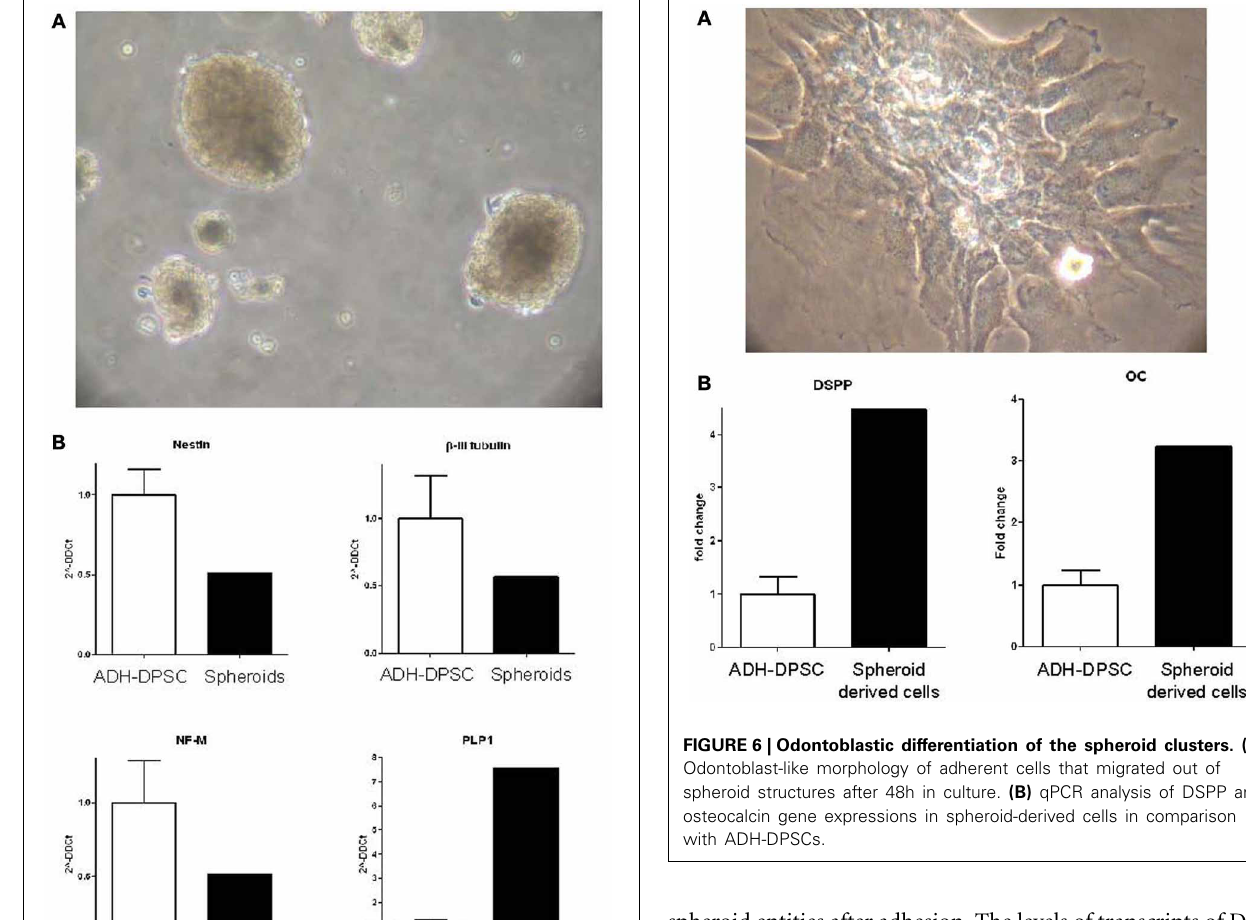
Characterization of the differentiation pattern of spheroid-derived DPSCs